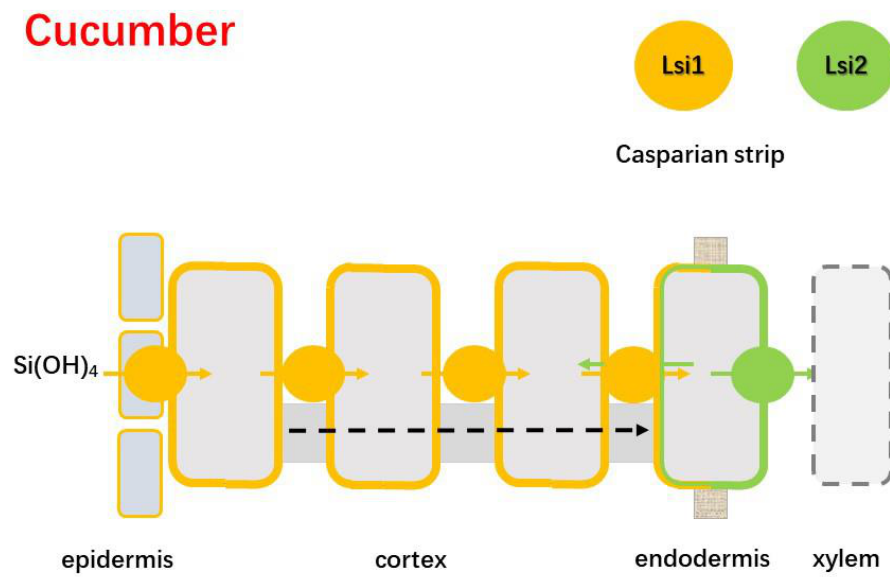
Figure 3. Schematic model of the Si transport system in cucumber.